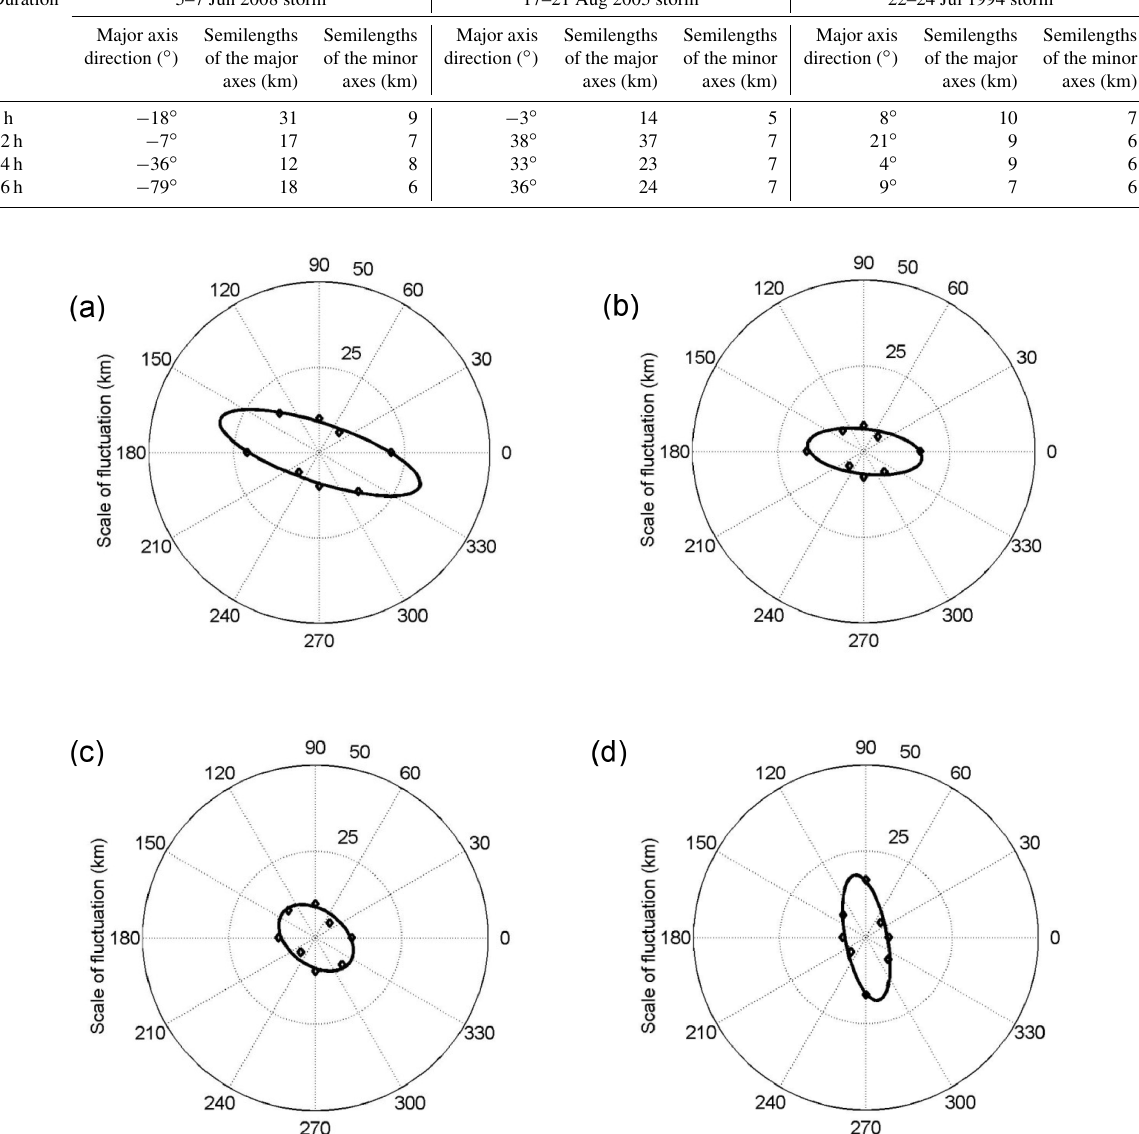
Figure 13. Scale of fluctuation values and ellipse-fitting curves for the 5–7 June 2008 storm: (a) maximum rolling 4h rainfall, (b) maximum rolling 12h rainfall, (c) maximum rolling 24h rainfall, and (d) maximum rolling 36h